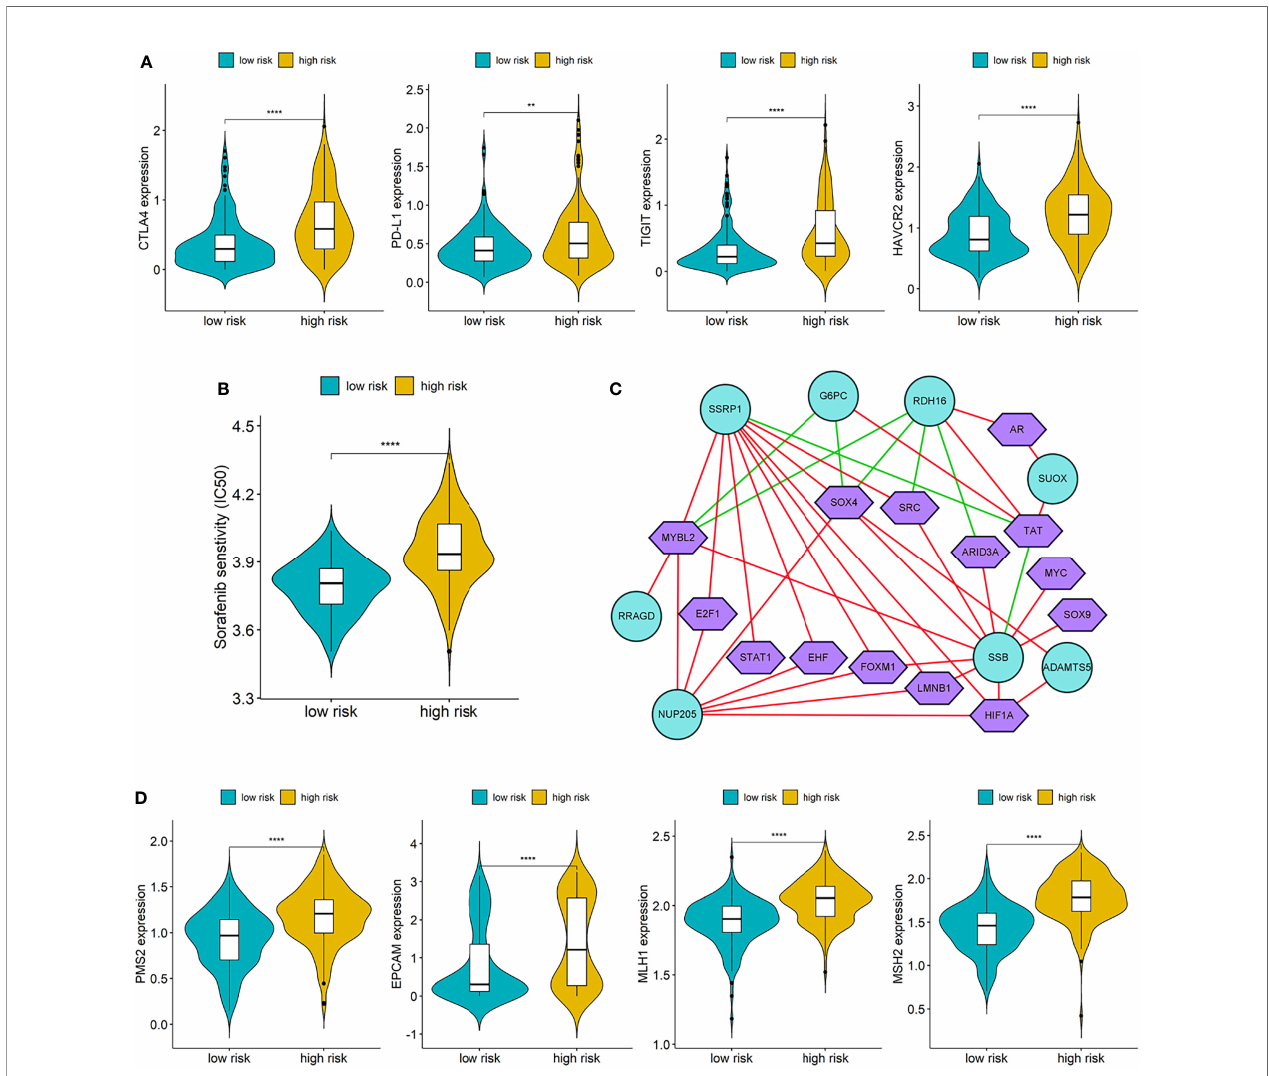
FIGURE 8 | (A) Differences of immune checkpoints between high risk group and low risk group; (B) Difference of Sorafenib sensitivity (IC50) between high risk and low risk patients; (C) The network diagram of the correlation between TFs and genes in the prognostic signature. Green circles represent genes in the signature and purple polygons represent TFs. The red lines indicate positive correlation and the green lines indicate negative correlation; (D) Differences of DNA damage repair related genes between high and low risk group. (**p < 0.01; ****p <